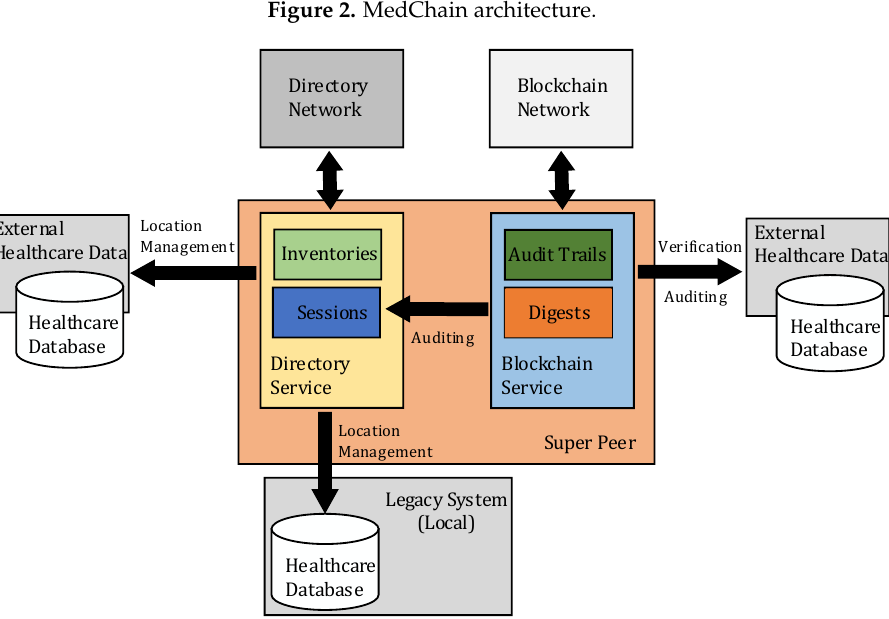
Figure 2. MedChain architecture.